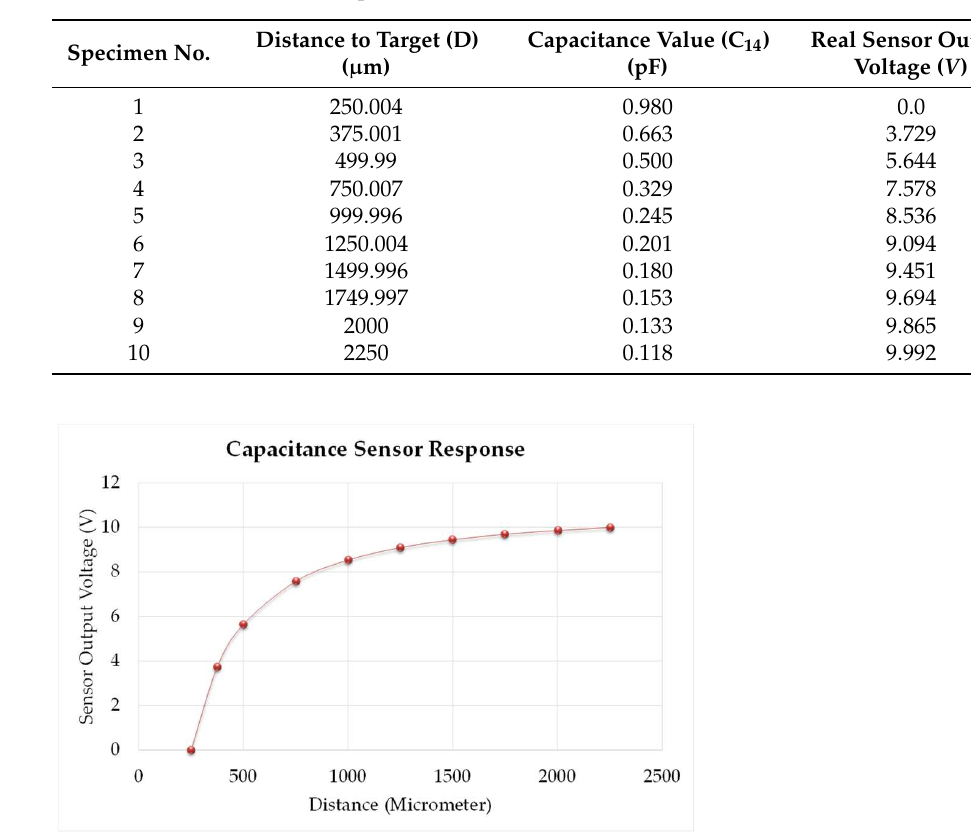
Table 2. Calibration of C1-A capacitance sensor.